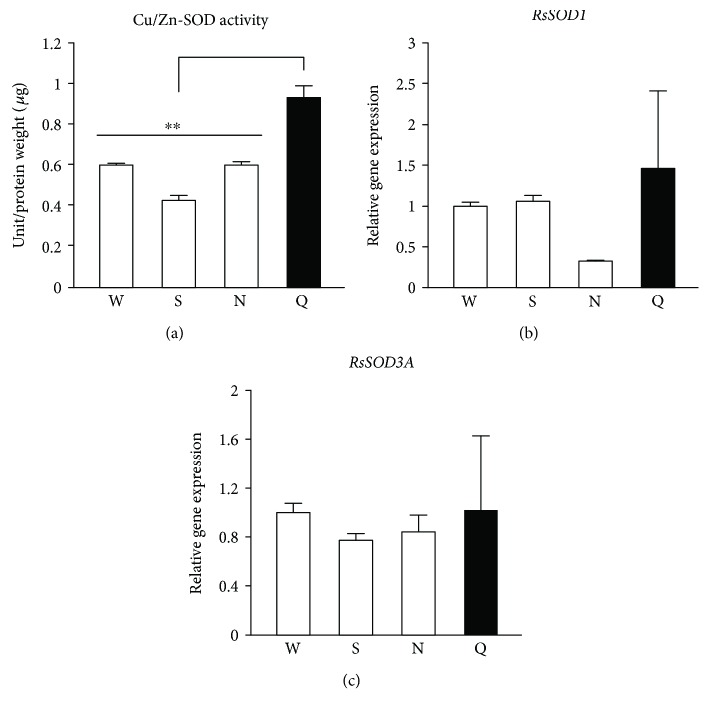
Cu/Zn-SOD activity and gene expression in R. speratus queens and nonreproductive individuals. (a) Queens (n = 9) showed higher Cu/Zn-SOD activity than nonreproductive workers (n = 6; P = 0.001), soldiers (n = 6; P < 0.001), and nymphs (n = 6; P = 0.001). (b) Queens (n = 9) did not have higher levels of RsSOD1 gene expression than workers (n = 12; P = 1.000), soldiers (n = 12; P = 1.000), or nymphs (n = 12; P = 1.000). (c) Queens (n = 9) did not have higher levels of RsSOD3A gene expression than workers (n = 12; P = 1.000), soldiers (n = 12; P = 1.000), or nymphs (n = 12; P = 1.000). We used pooled samples, as described in Table
S1, for several replications. White and black bars indicate nonreproductive individuals and queens, respectively. Error bars represent SEM. Significance was measured by unpaired t-test followed by Holm's adjustment (∗∗
P < 0.01). W: workers; S: soldiers; N: nymphs; Q: queens.